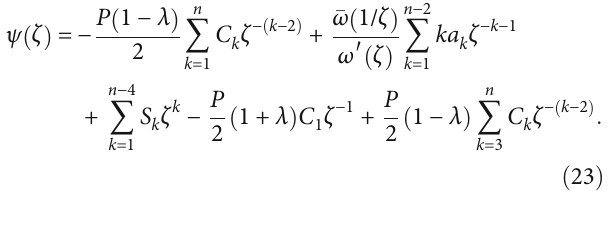
Figure 3: Contours of stresses (in Pa) around the tunnel by ANSYS.